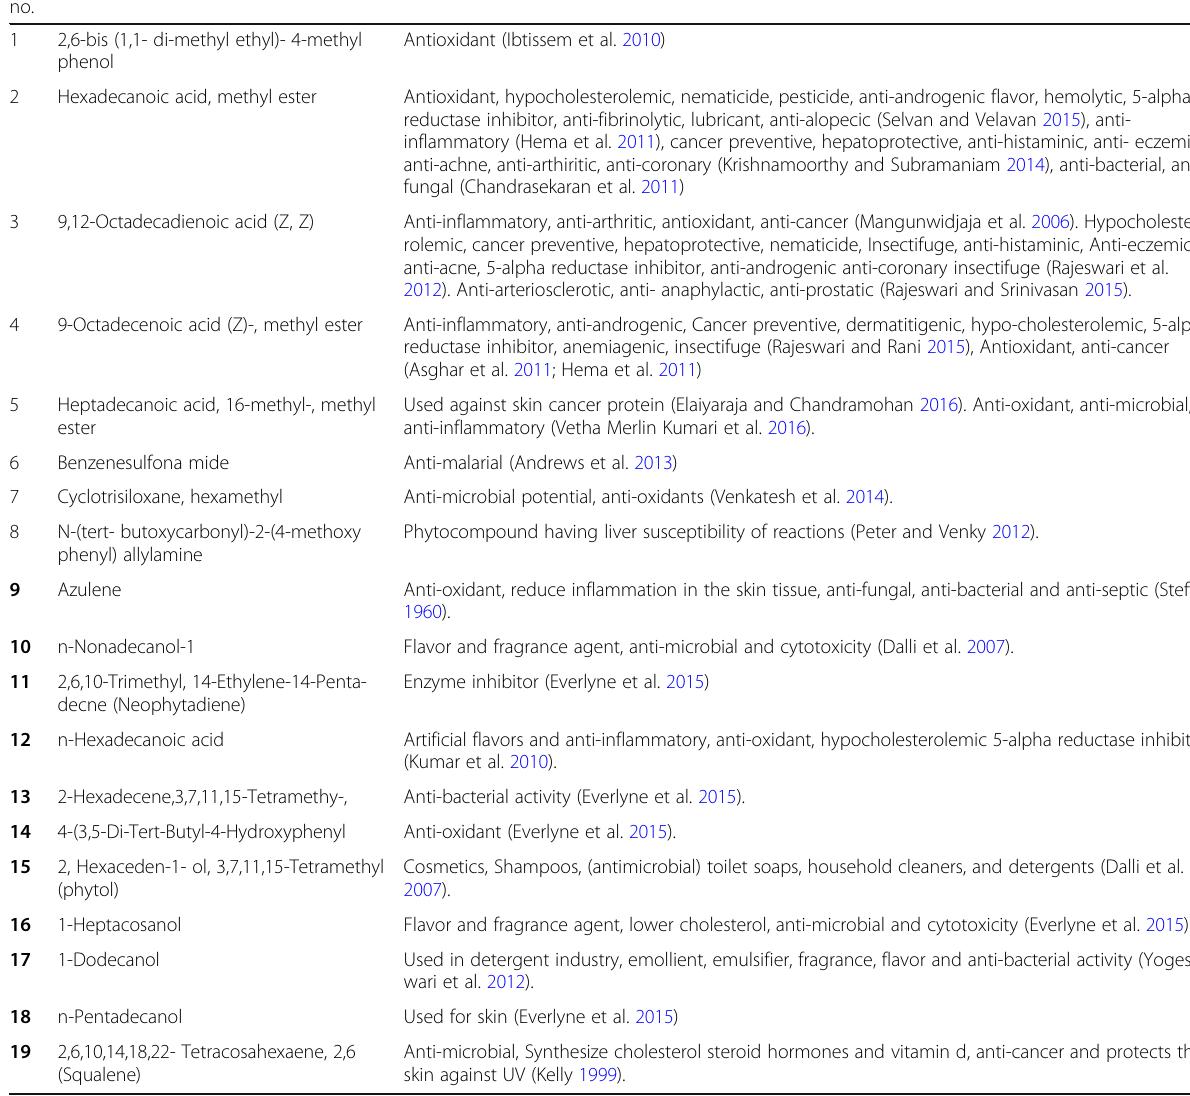
Table 2 Pharmacological compounds present in different extracts of S. kunthiana Sr. no.